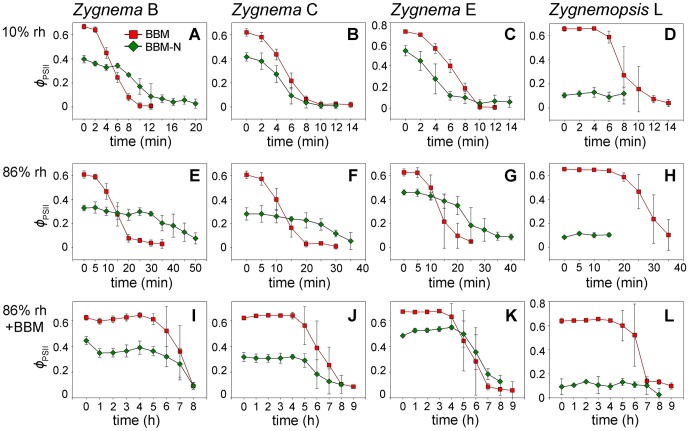
Effective quantum yield (Φ
PSII) under different desiccation scenarios.
A–D: rapid desiccation, approximately 10% relative humidity (rh); E–H: slow desiccation, 86% rh; I–L: very slow desiccation, 86% rh plus additional moistening of samples with 10 µl BBM. All strains shown were pre-cultivated on regular agar medium (A BBM) or on medium without nitrate (A BBM-N). Results are means ± standard deviations of four independent experimental replicates.